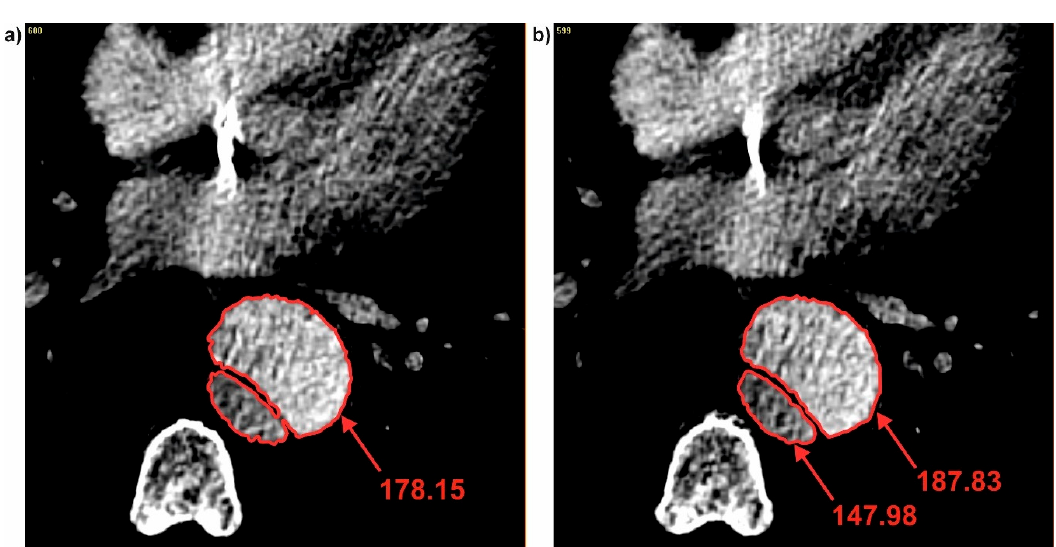
Figure 8. Brightness changes during channel division: ( a ) Common duct and ( b ) true and false duct. Values of brightness were calculated in pixels.